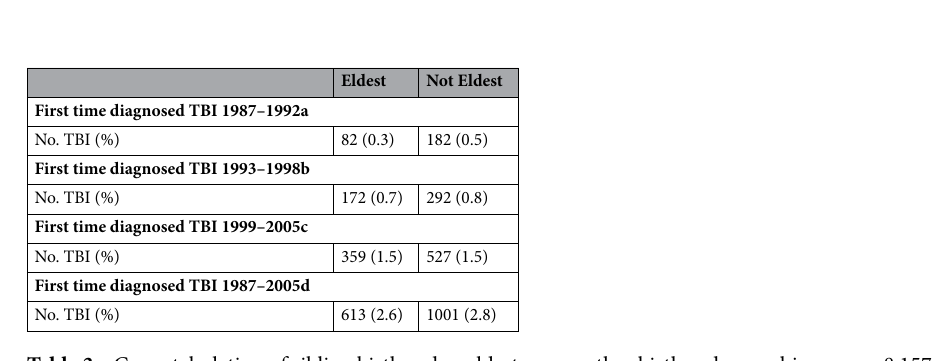
Table 3. Cross-tabulation of sibling birth order: eldest versus other birth orders. a chi-square = 8 157, d.f. = 1, P = 0 004. b chi-square = 1 291, d.f. = 1, P = 0 256. c chi-square = 0 291, d.f. = 1, P = 0 590. d chi-square = 1 909, d.f. = 1, P = 0